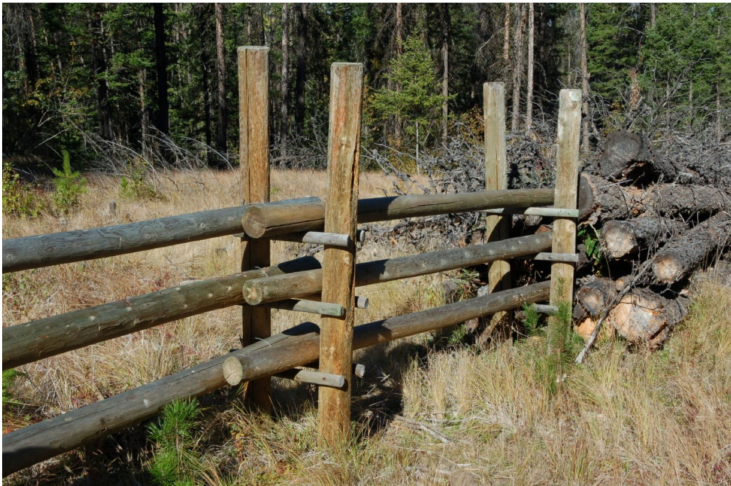
Figure 13. Wildlife/cattle gate and removable rails. (Photo by A.